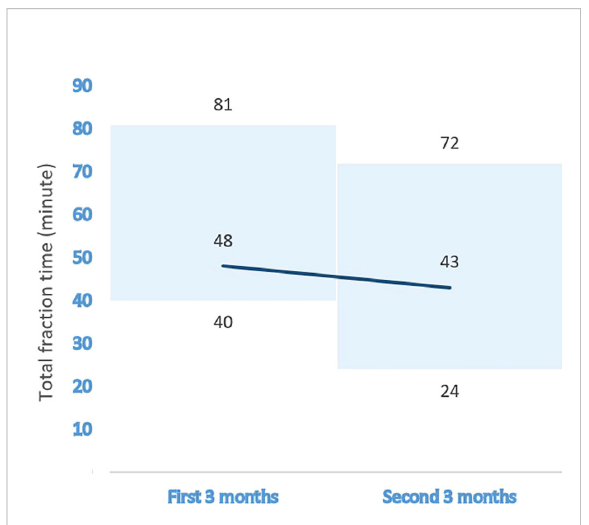
FIGURE 1 The effect of the learning curve on the median treatment time for MRI-guided prostate cancer radiotherapy.